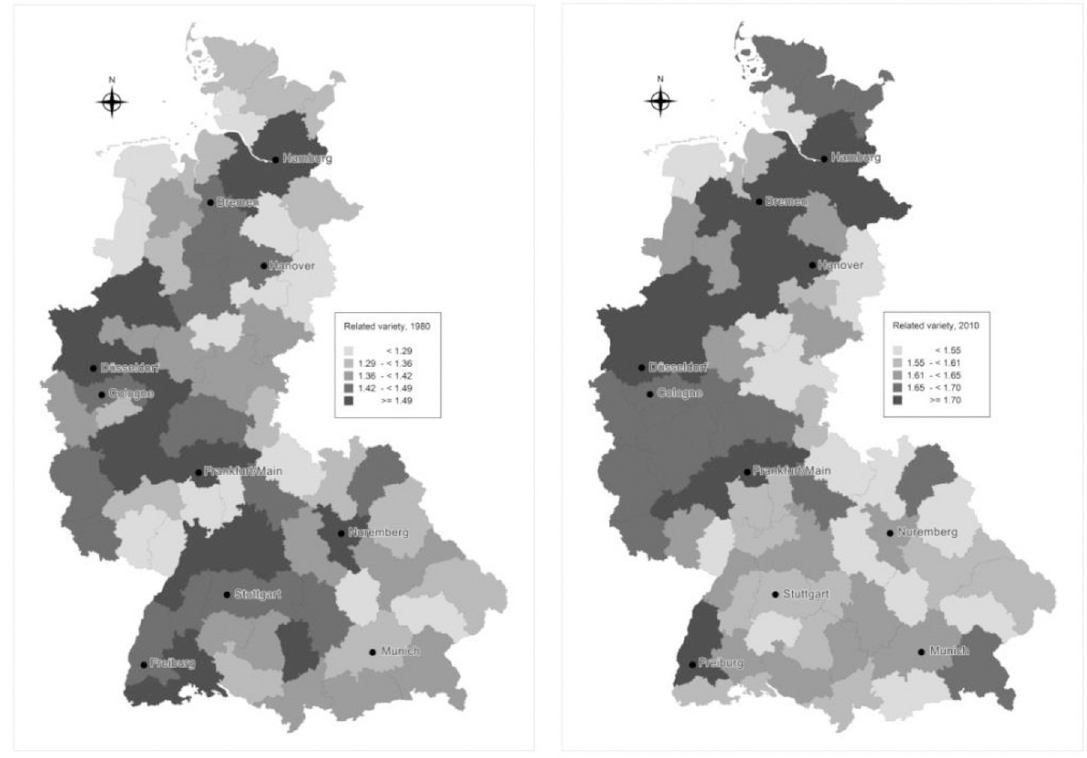
Fig 5. Related variety in 1976 (on the left) and 2010 (on the right). Source: Authors.